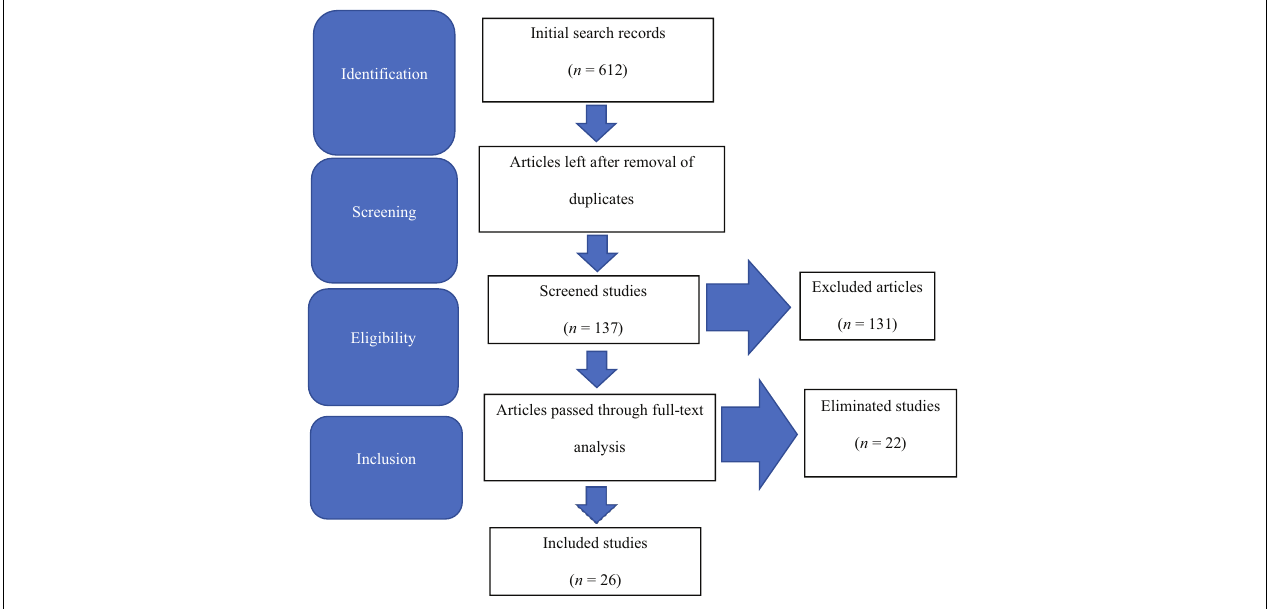
FIGURE 1 | Preferred Reporting Items for Systematic Review and Meta-analysis (PRISMA)